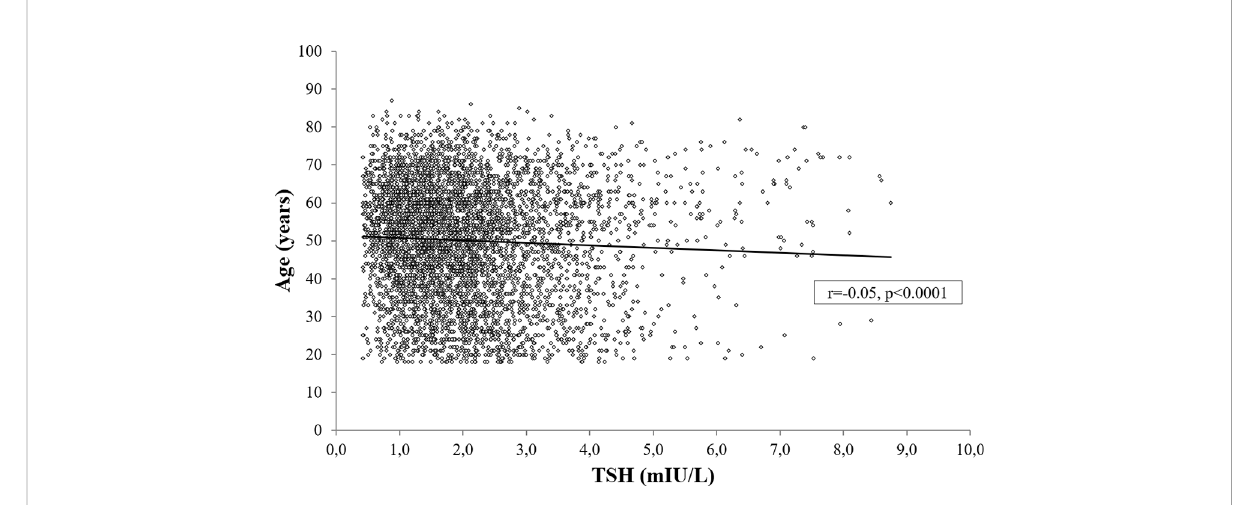
FIGURE 5 Bivariate correlation analysis between serum TSH and age.